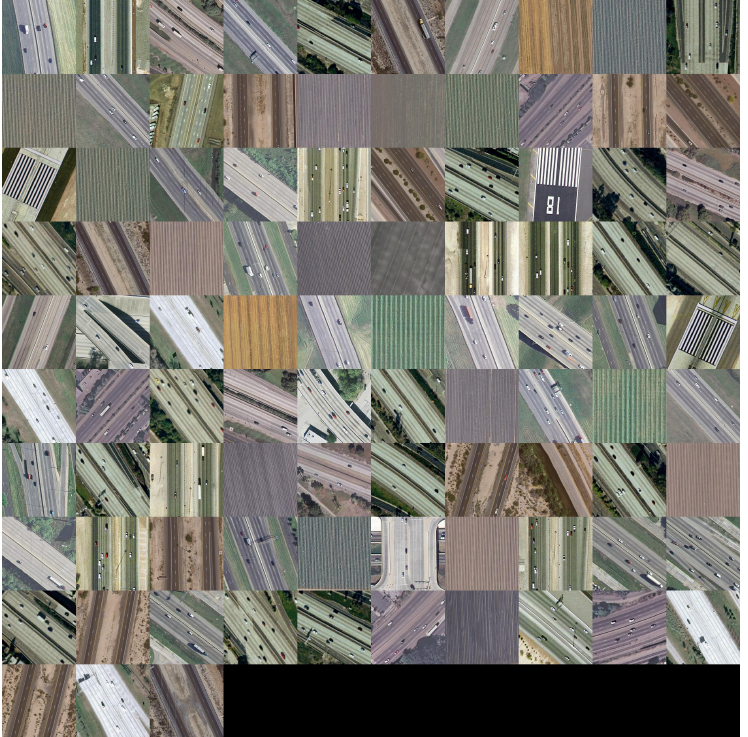
Figure A2. The remote sensing images of freeway clustered by clustering-based method [30]. There are 93 images in total, and 68 images contain